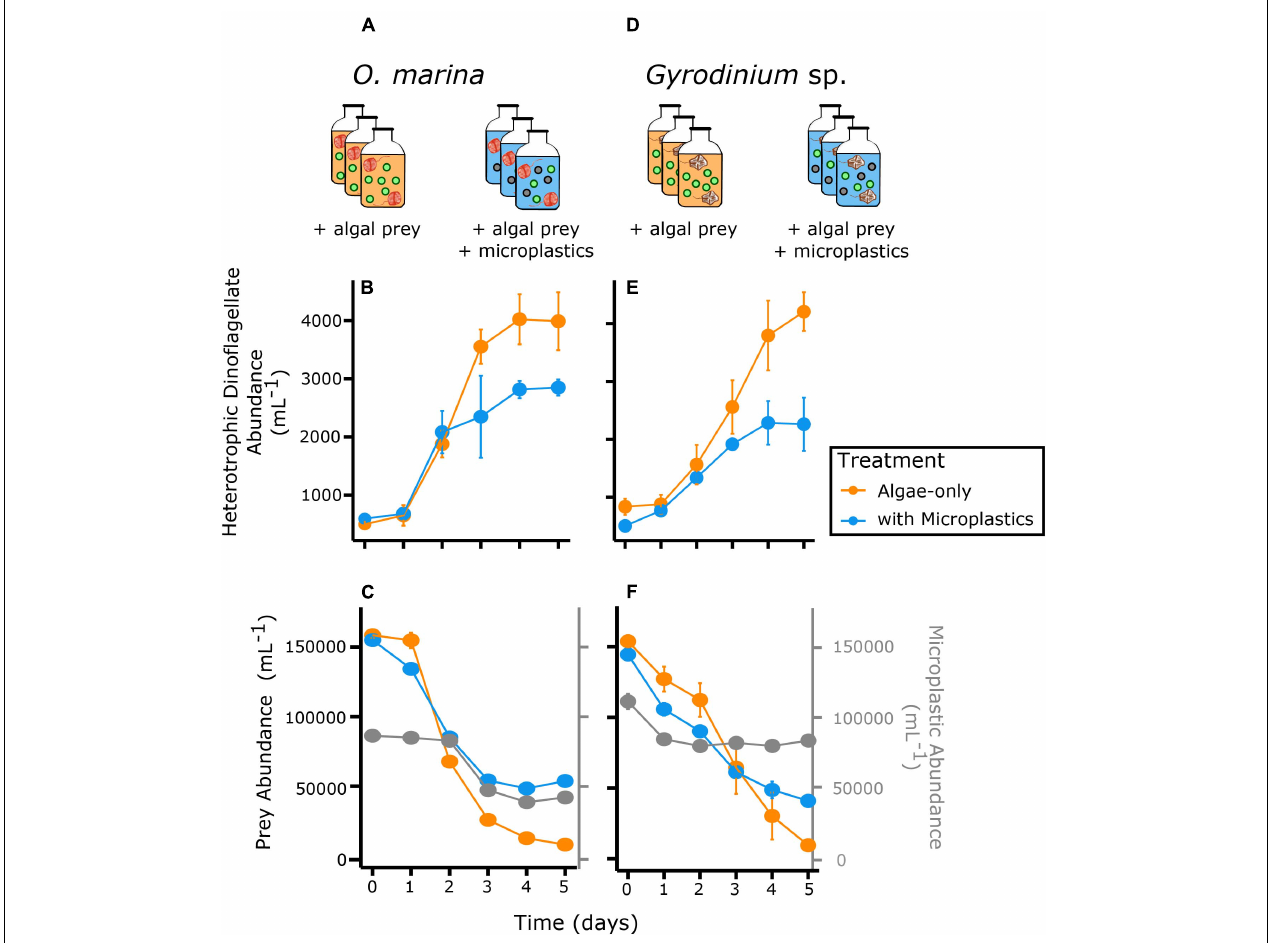
FIGURE 2 | Abundance of heterotrophic dinoflagellates in two feeding treatments, algae only (orange) and a mixture of microplastics with algal prey (blue) over time. The top row shows the experimental setup, with triplicate bottles of each treatment for each species. The second row shows abundance of O. marina (A–C) and Gyrodinium sp. (D–F) and third row, abundance of prey and microplastics for the respective predator treatments. Gray points represent the microplastic particle abundance in the treatments with microplastics. Error bars indicate one standard deviation of the mean, which is contained within the symbol for many